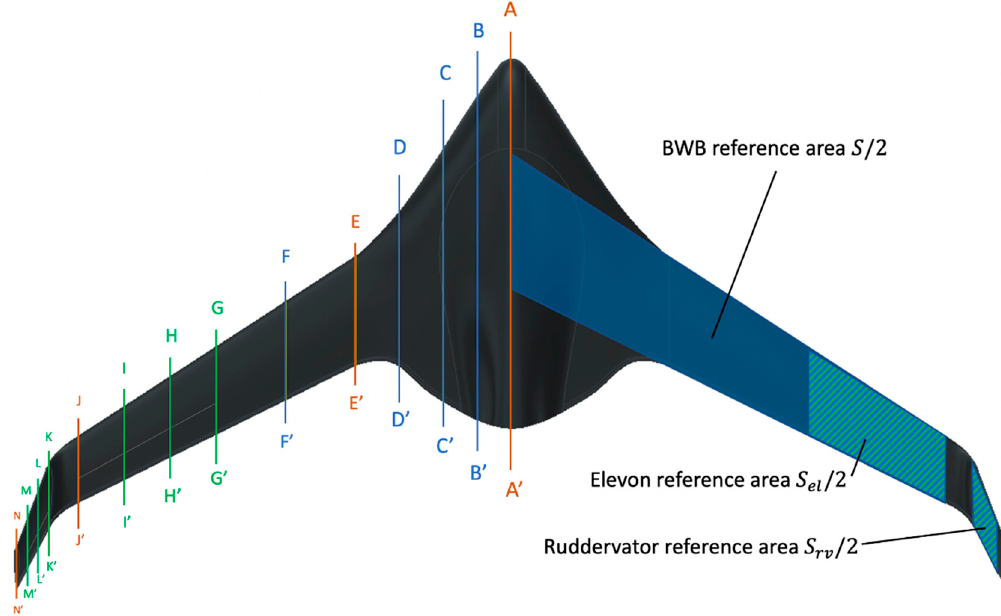
Figure 3. Division of the reference BWB UAV platform in spanwise sections. Sections marked in orange correspond to the predefined ones, sections marked in blue and green to correspond the ones generated by lofting. Green is also used to define control surfaces area and frames.